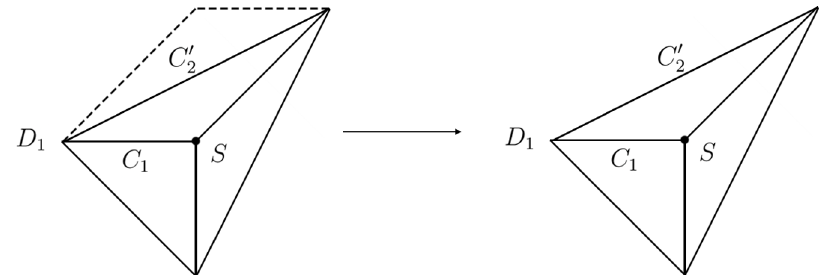
Figure 20 . The local P 2 geometry as part of the flopped F 1